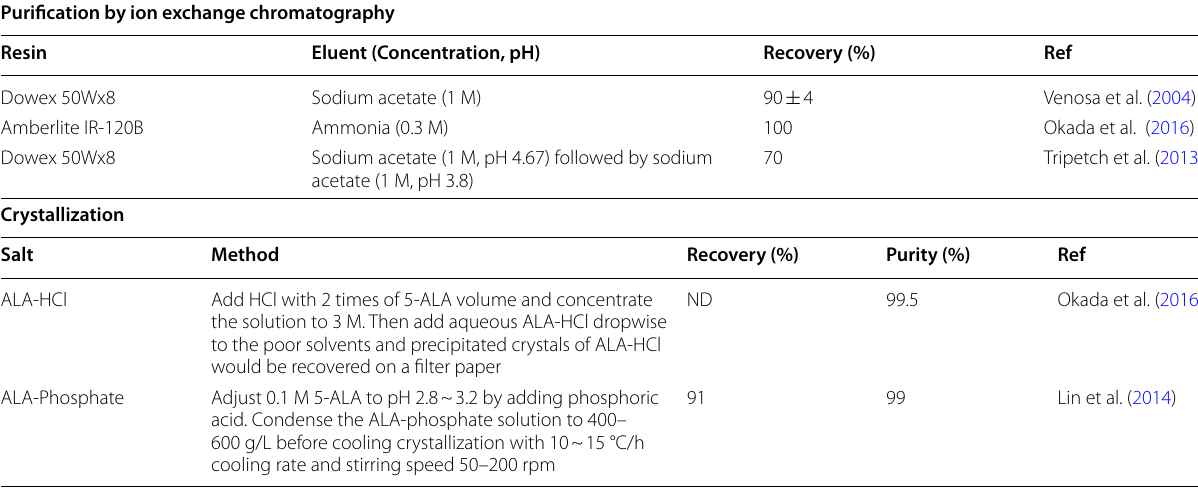
Table 5 Purification condition and crystallization for 5‑ALA salts Purification by ion exchange